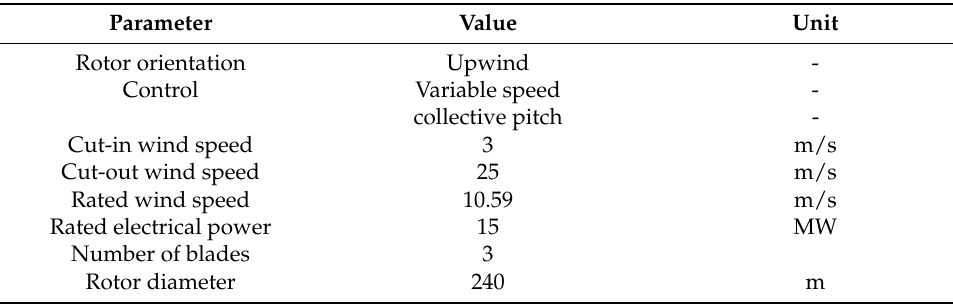
Figure 3. Simulation model of 15 MW floating wind turbine with UMaine VolturnUS-S semi- submersible floating platform and mooring system for water depth of 70 m. Table 2. IEA 15 MW Wind-Turbine Specifications.